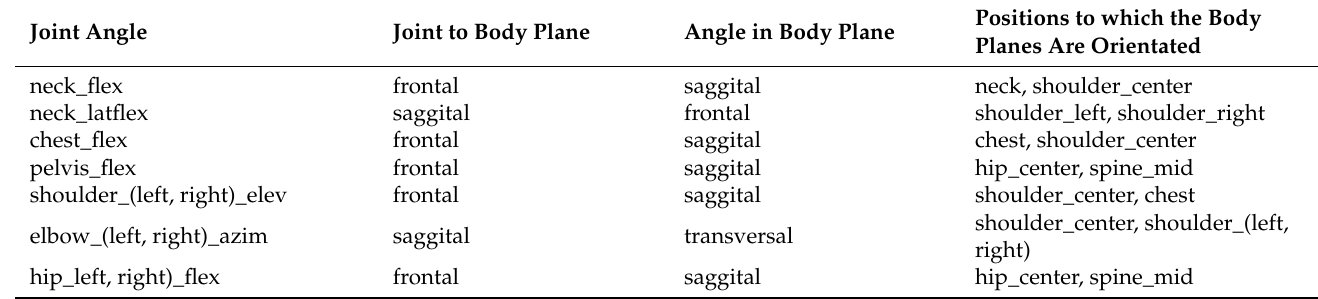
Table 2. Joint angles with reference to body planes and positions to which the local body planes are orientated. Joint Angle